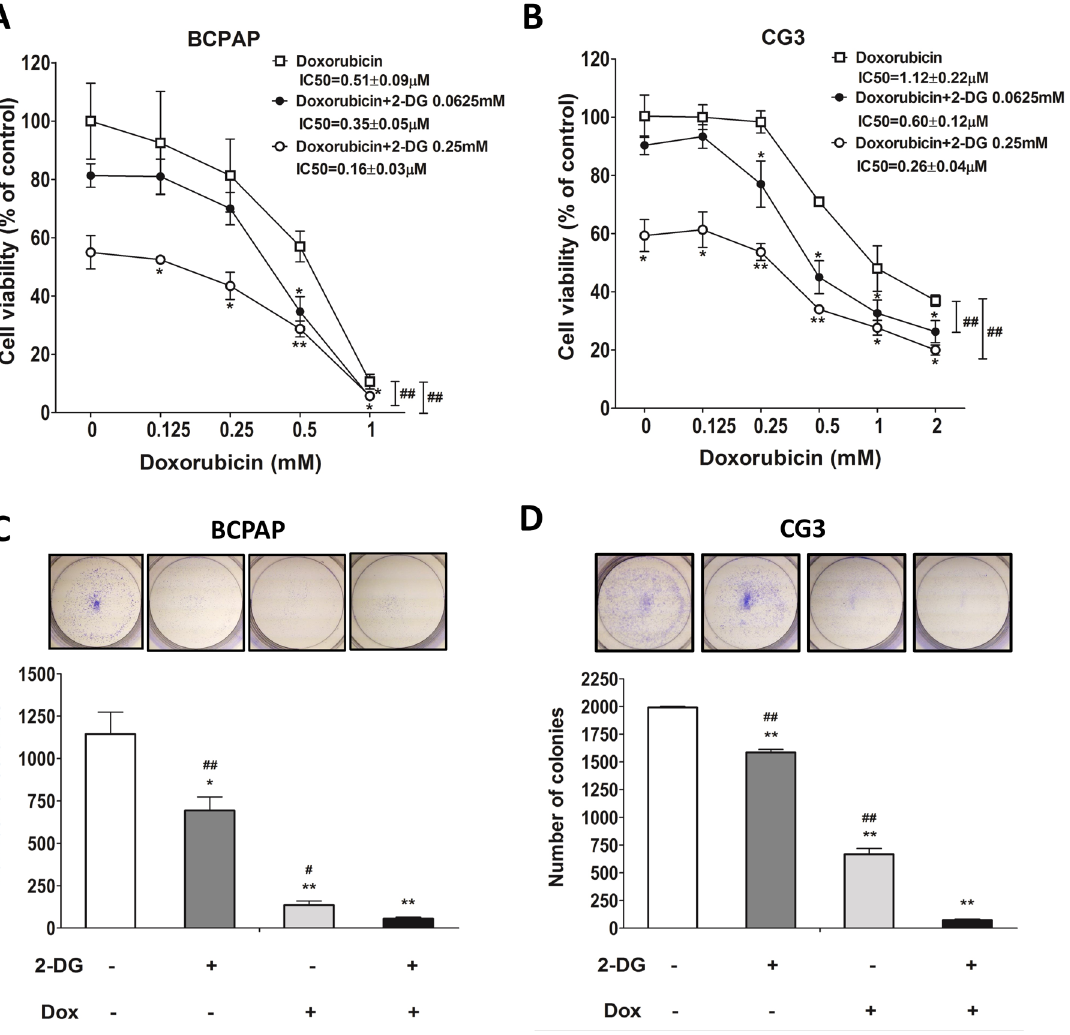
Fig 4. Effects of doxorubicin on the viability of PTC cells treated or not with 2-DG. (A, B) BCPAP and CG3 cells cultured in medium supplemented with 10% fetal bovine serum were treated for 48 h with different concentrations of doxorubicin in the presence or absence of 2-DG. Post-treatment, cell viability was measured using a WST-1 assay. (C, D) Colony formation in BCPAP and CG3 cells treated for 48 h with 1 mM 2-DG, 0.5 μ M doxorubicin, or both. The medium was replaced with fresh medium for 3 – 5 days to check for colony formation. * p < 0.05, ** p < 0.001, compared to the controls ( t test); panels A, B: ## p < 0.001, 2-way ANOVA; C, D: ## p < 0.001, compared to 2-DG plus doxorubicin treatment ( t test). Data are presented as means ± standard deviation